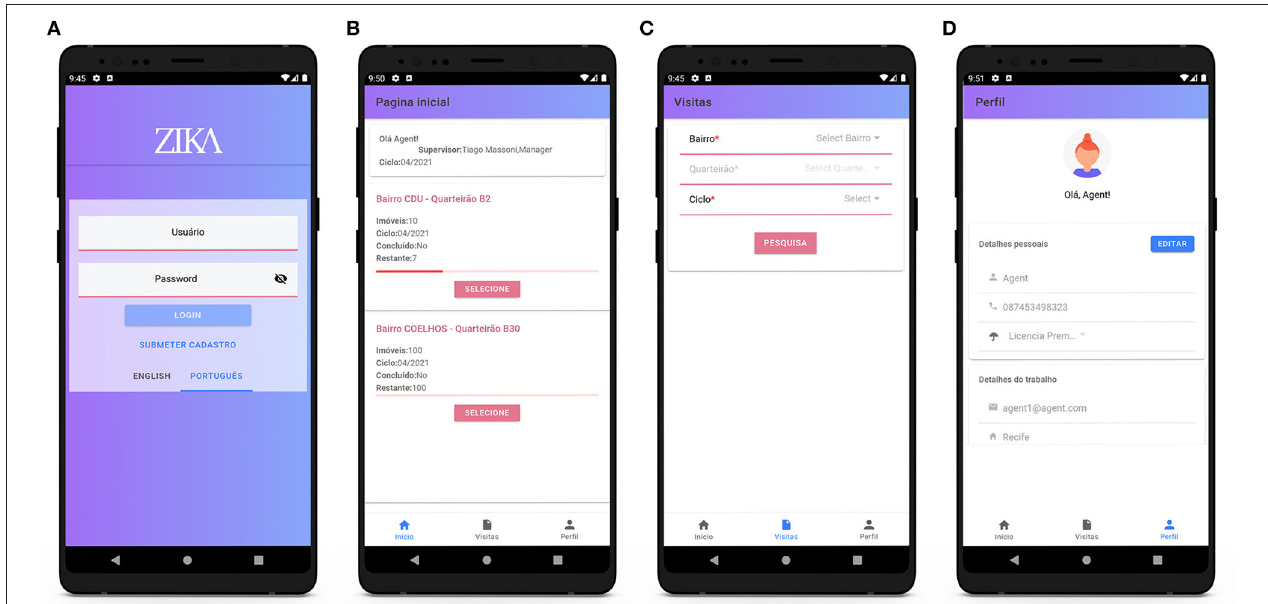
FIGURE 6 | Surveillance agents’ mobile application: login page and the three main pages of the application. (A) Login page, (B) home page, (C) past visits, and (D) profile page.